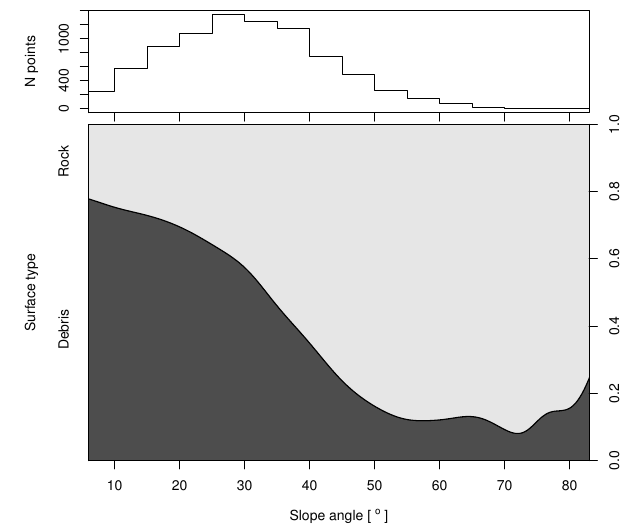
Fig. 1. Conditional density plot for the two surface classes debris and rock (derived from Vector25) in relation to slope angle. Above, the number of points that are used for this analysis are shown in relation to slope